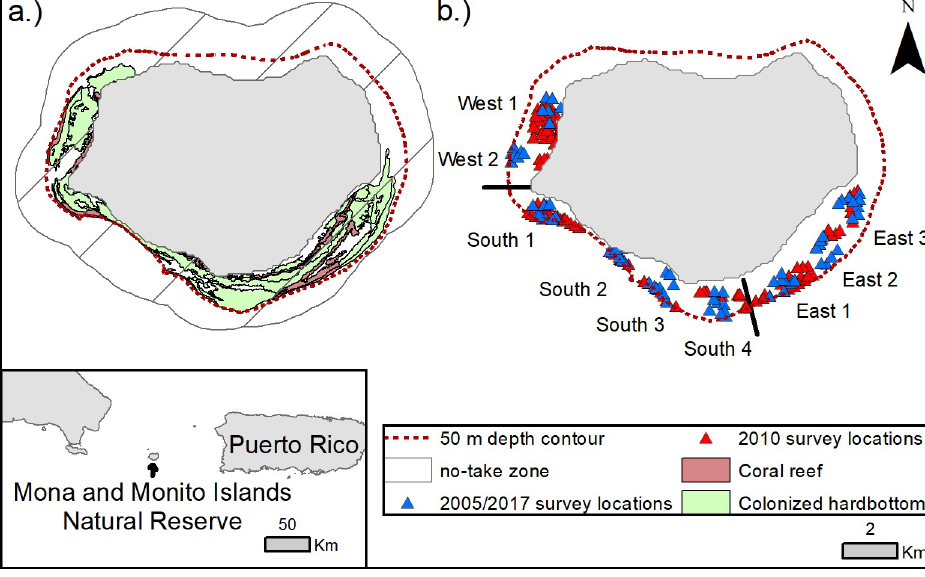
Fig 1. Maps of the Mona Island study area. aCurrent NTZ boundary with coral reef and colonized hardbottom habitat extent, and sampling locations from 2005, 2010, and 2017 (b).